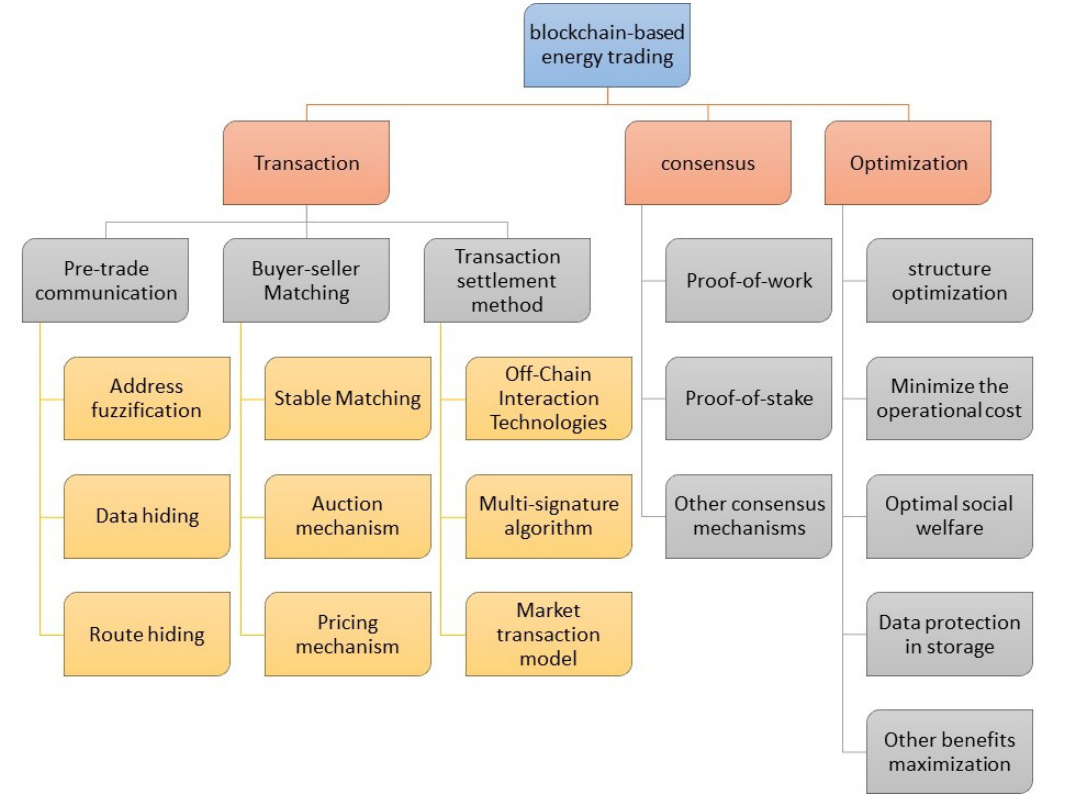
Figure 2. Classification of Blockchain-based Energy